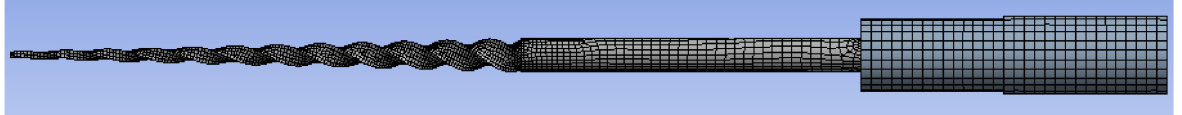
Fig. 3. Meshed model of hyplex CM endodontic fi le.